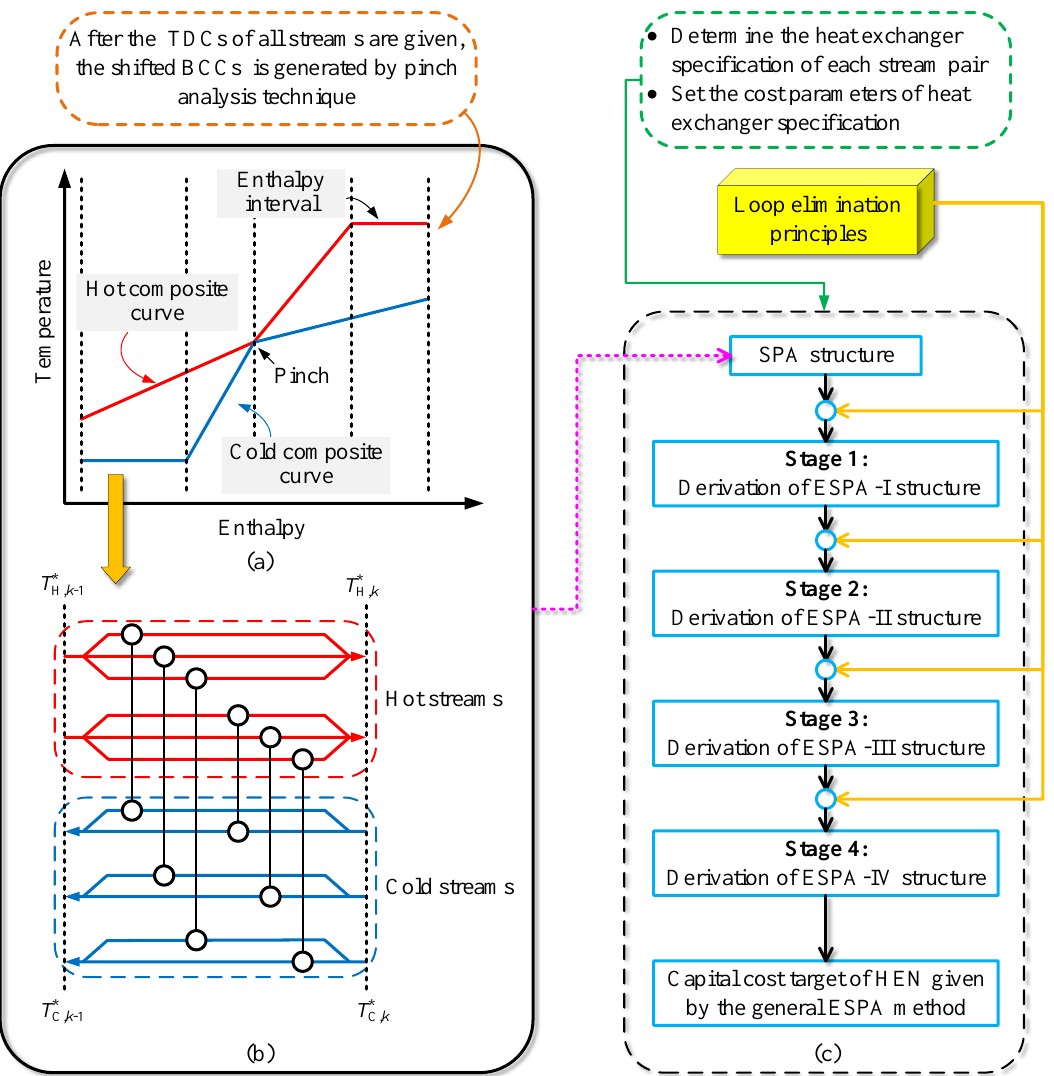
Figure 1. Derivation of the general ESPA method: ( a ) shifted BCCs for the HEN; ( b ) match distribution in enthalpy interval k of the SPA structure; ( c ) evolution flowchart of ESPA structures.